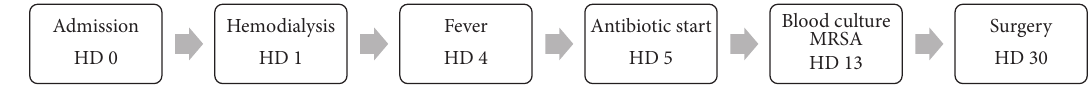
Figure 2: Hospital course.